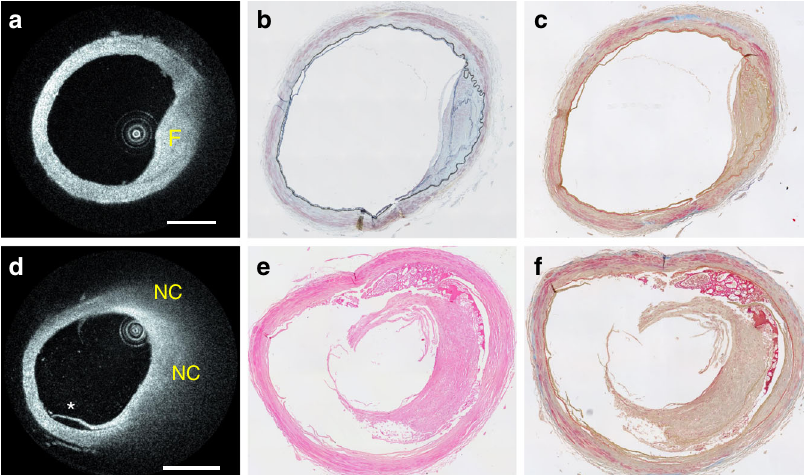
Fig. 7 Intracranial plaques from an ex vivo segment of the MCA artery. a HF-OCT imaging of a fi brotic plaque and corresponding trichrome b and Movat ’ s staining c . Fibrotic tissue is characterized by HF-OCT as a region of homogenous signal, resulting from elevated backscattering and low optical attenuation coef fi cients. d HF-OCT imaging of a necrotic core plaque and corresponding H&E e and Movat ’ s staining f . A necrotic core plaque is characterized on HF-OCT images as an area with poorly delineated borders followed by an elevated optical attenuation coef fi cient within an atherosclerotic plaque. The asterisk indicates a vessel wall dissection. From n = 10 cadaveric specimens of intracranial arteries, a total of n = 3 representative atherosclerotic plaques were identi fi ed, processed for histopathology analysis, and compared to HF-OCT imaging. Scale bars are equal to 1.0